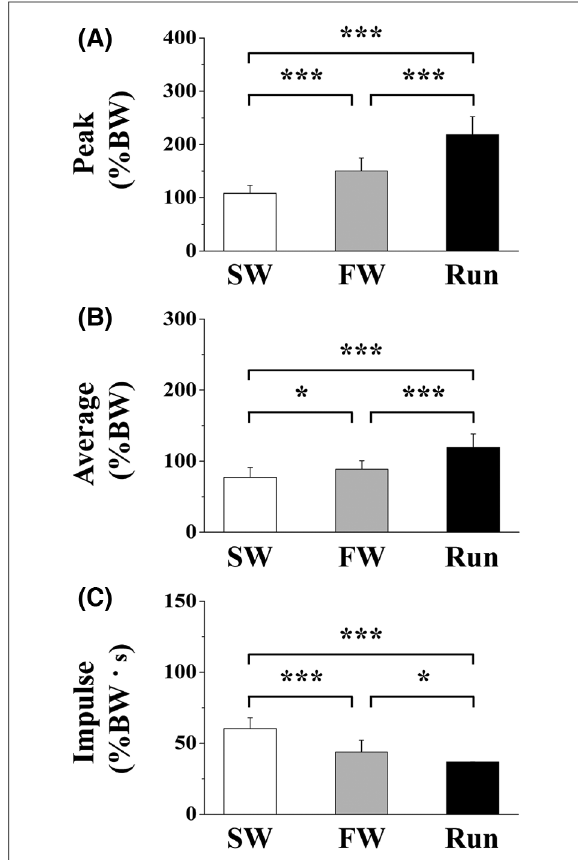
FIGURE 4 The peak ( A ), average ( B ) and impulse ( C ) of vertical component of ground reaction force. Values are means±SD. Signi fi cant